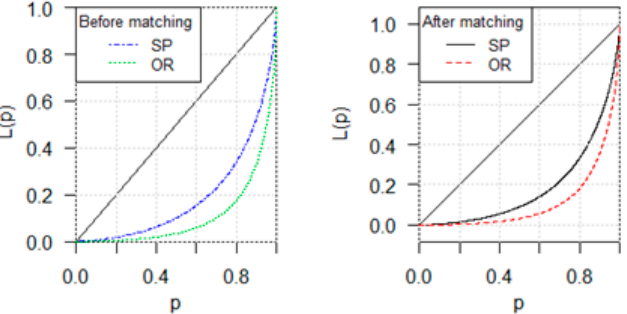
Figure 4. Lorenz Curve of the Empirical Experimental Data on Patient and Views Before Matching and After Matching. The Horizontal Axis Represents the Rank Percentile 𝑝 of Severed Patients. Table 4. Statistics (Gini Coefficients) of the Empirical Experimental Data.